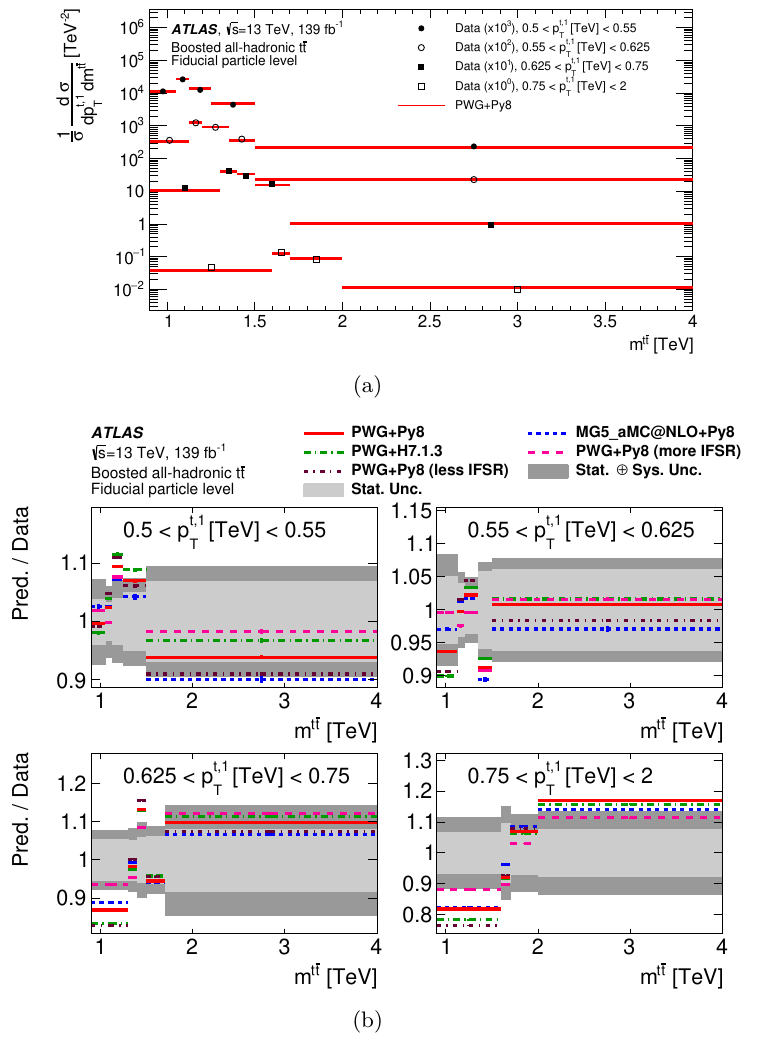
Figure 16 . (a) Normalized particle-level fiducial phase-space double-differential cross-sections as a function of the p T of the leading top-quark jet and the invariant mass of the t ¯ t final state, m t ¯ t , compared with the Powheg+Pythia 8 calculation. Data points are placed at the centre of each bin and the Powheg+Pythia 8 calculation is indicated by solid lines. The measurement and the prediction are normalized by the factors shown in parentheses to aid visibility. (b) The ratios of various MC calculations to the normalized particle-level fiducial phase-space differential cross-sections. The dark and light grey bands indicate the total uncertainty and the statistical uncertainty, respectively, of the data in each